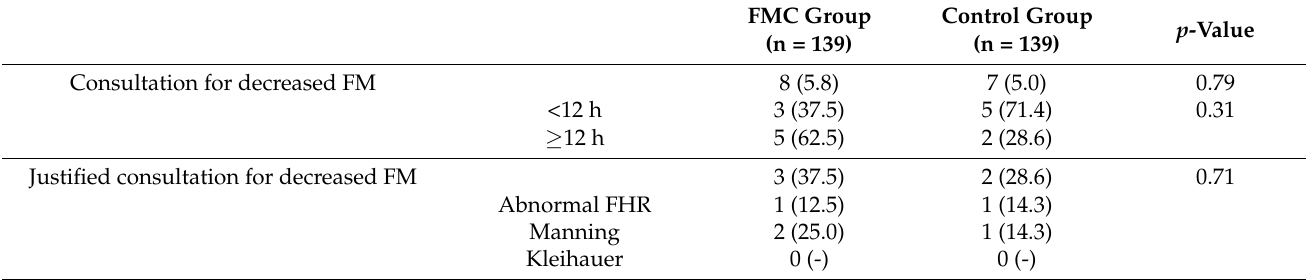
Table 3. Outcomes related to consultations for decreased FM. Data are expressed as n